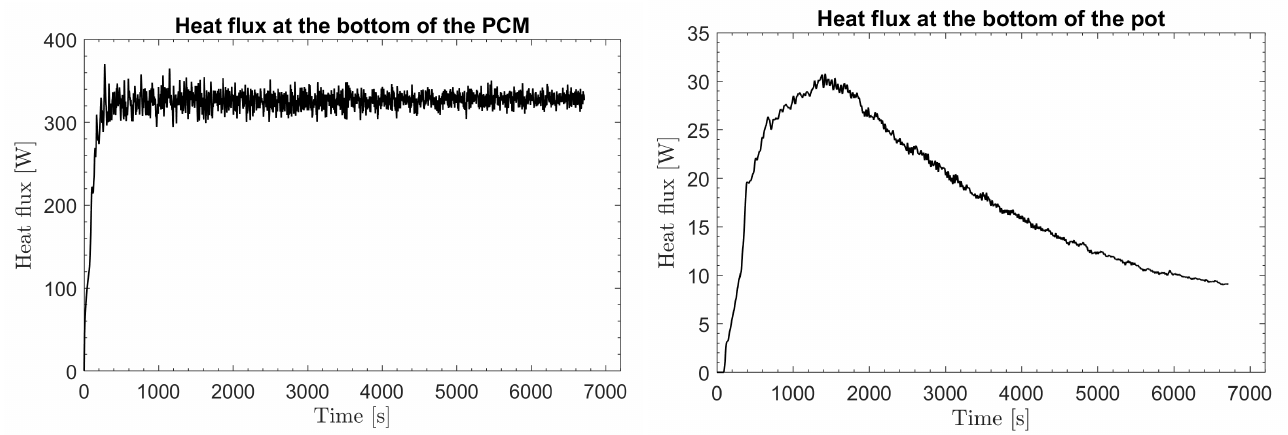
Figure 6. Heat fluxes through the bottom of: ( Left ) the TES and ( Right ) the